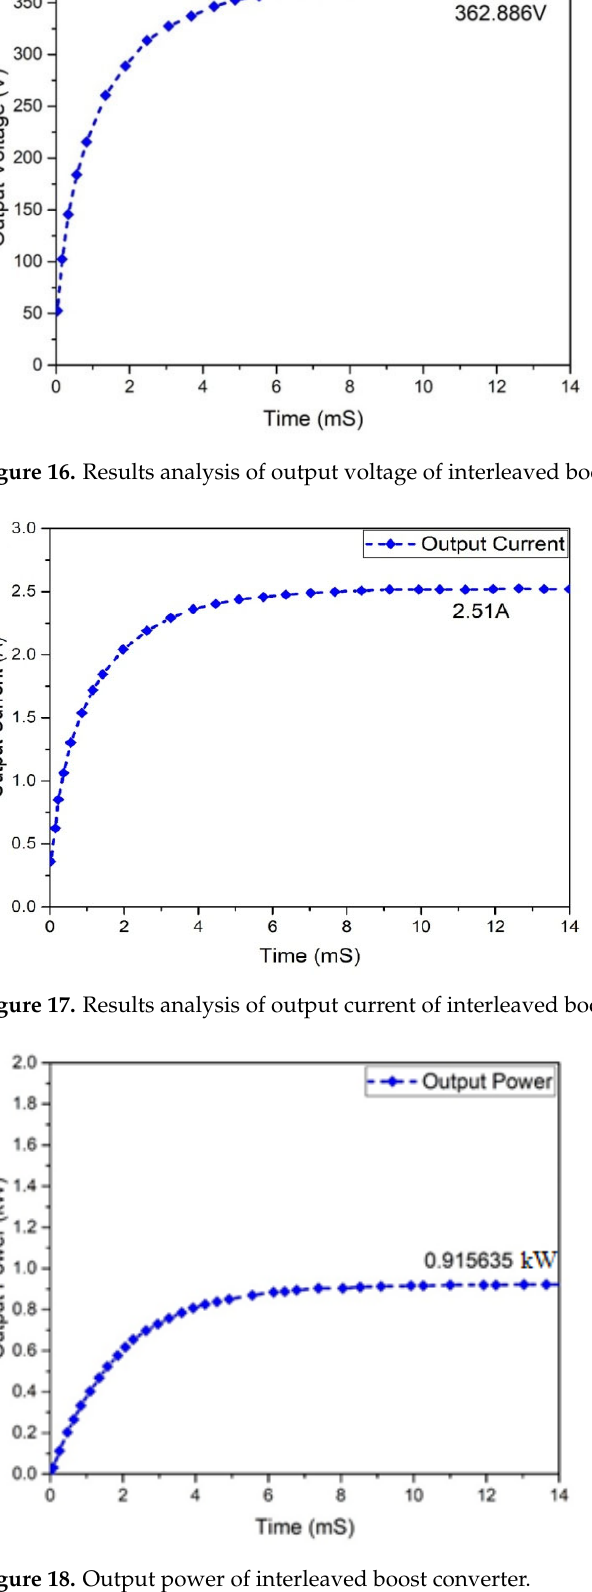
Figure 19. Input power analysis of interleaved boost converter.